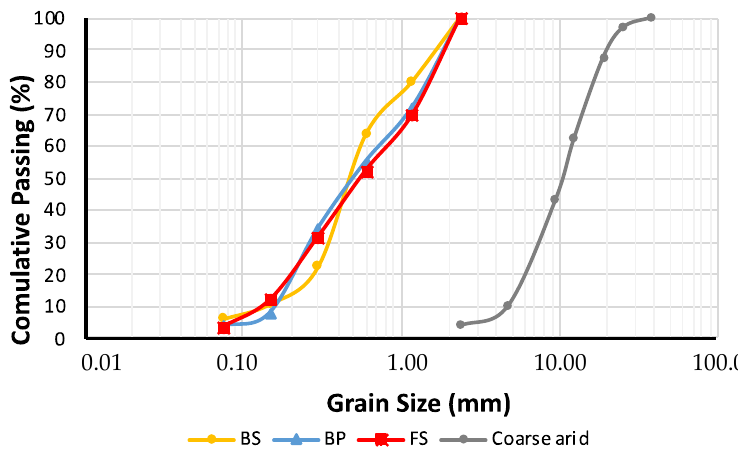
Figure 2. Cumulative passing of the three sands and coarse aggregate.